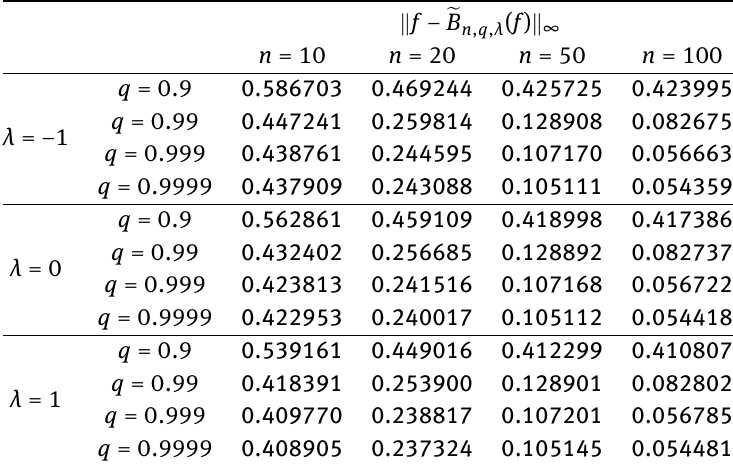
Table 1: The errors of the approximation of (cid:101) B n , q , λ ( f ; x ) to f ( x )